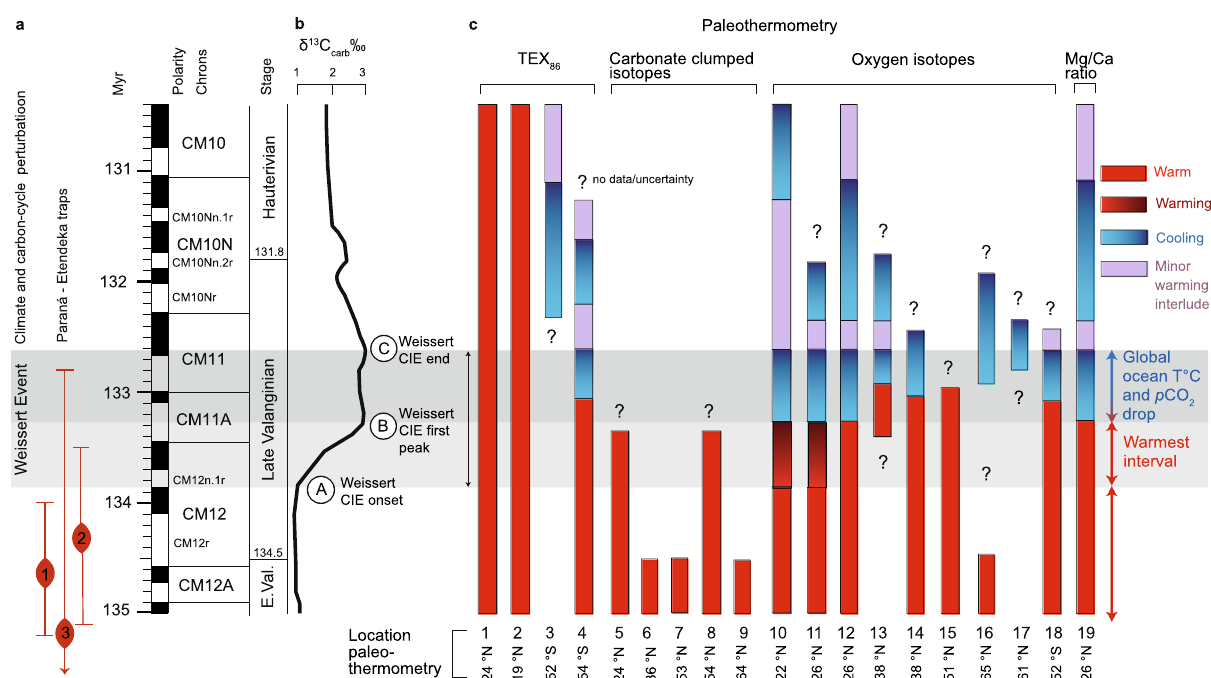
Fig. 3 Chronological framework of the Weissert Event and evolution of worldwide multi-proxy ocean temperature trends. a Chronostratigraphy of climate and carbon-cycle (Weissert) perturbation event and Paraná-Etendeka timing after (1) 67 , (2) 68 and (3) 69 ; numerical ages in Myr are based on boundary ages of polarity chrons 57 revised in this study for the position of the Valanginian/Hauterivian boundary 56 . b Identi fi cation of the Weissert positive carbon isotope excursion (CIE) is based on the reference carbon isotope record measured on bulk carbonate ( δ 13 C carb ) 25 calibrated in the Southern Alps in the uppermost part of magnetic chron CM12 (A, CIE onset) and in the upper part of magnetic chron CM11 (C, CIE end) 9 . c A detailed correlation to available global multi-proxy-based ocean temperature records is presented by coloured bars (e.g., red (relatively stable warm interval), graded red to darker red (warming interval), blue to darker blue (cooling interval), and lilac (minor warming interlude)), which graphically represent the reconstructed ocean temperature trends organized by type of proxy (e.g., TEX 86 , carbonate clumped isotopes, oxygen isotopes and Mg/ca ratio paleothermometry). Note that numbered section/site locations of the reported proxy compilation are shown in Fig.